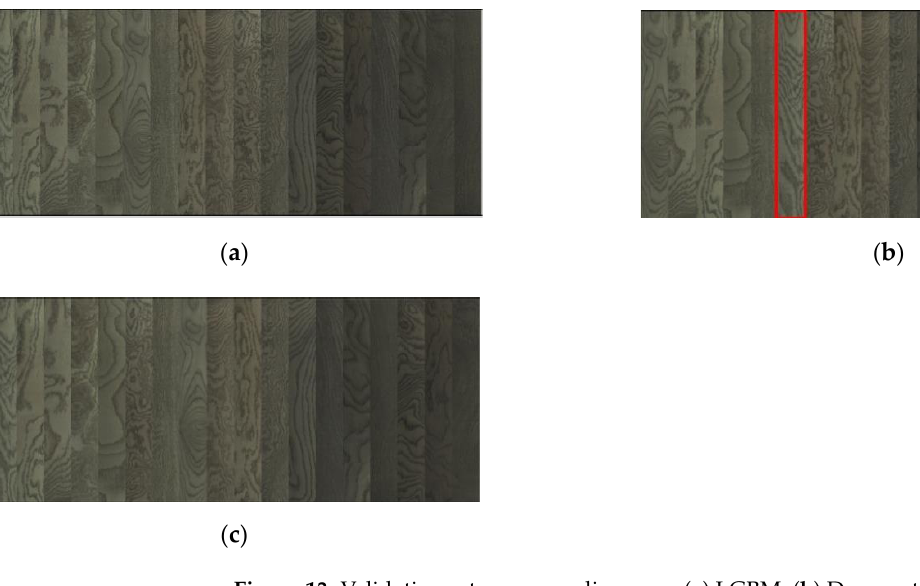
Figure 13. Validation set sequence diagrams. ( a ) LGBM. ( b ) Densenet121. ( c ) Vision Transformer.